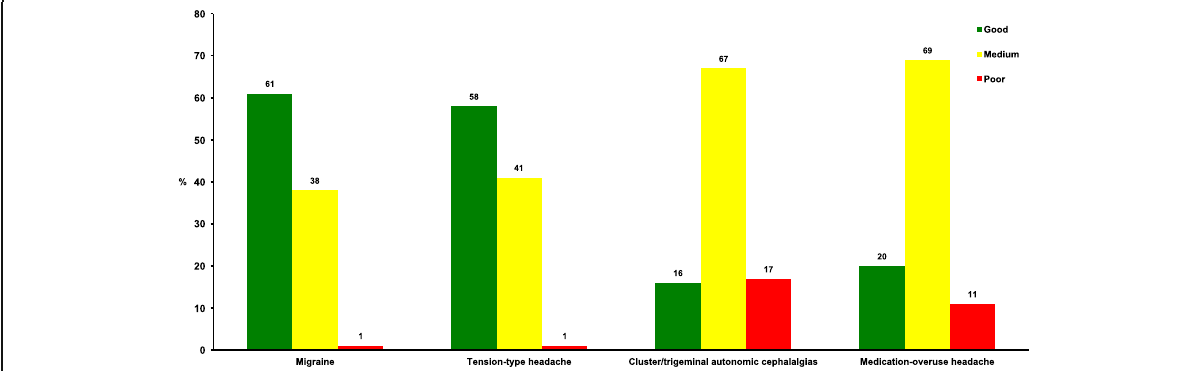
Fig. 2 Percentage of the participants responding good (green), medium (yellow), or poor (red) to the question “ How do you rate your own knowledge of migraine, tension-type headache, cluster headache/trigeminal autonomic cephalalgias, and medication-overuse headache?